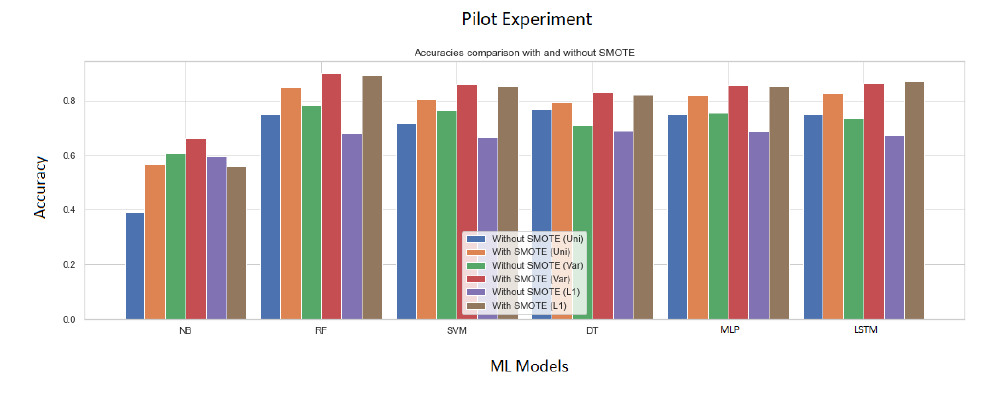
Figure 8. Exp3 Pilot